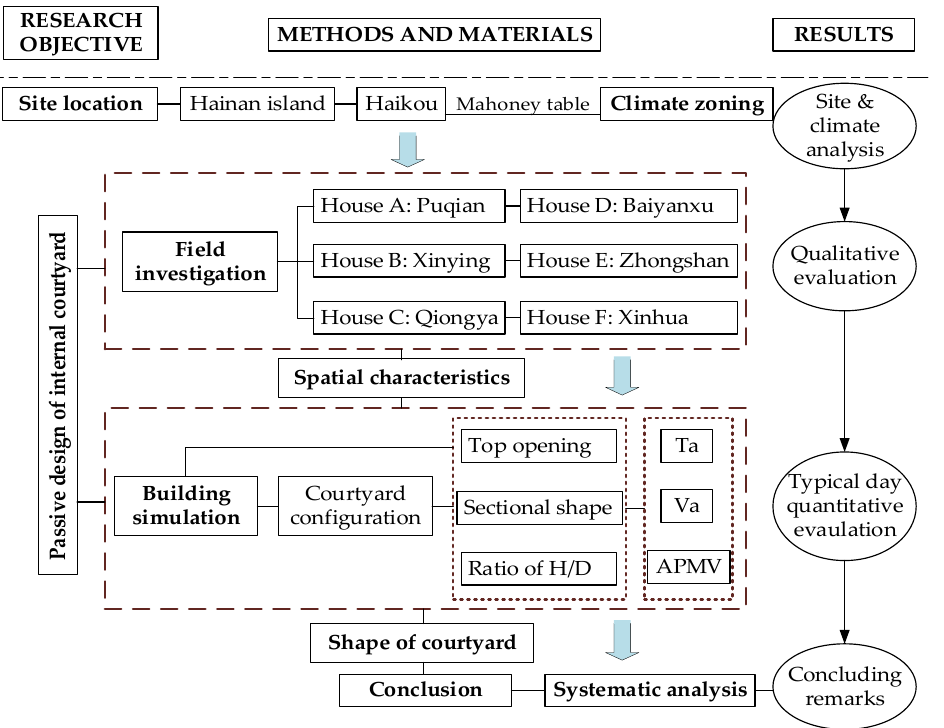
Figure 2. Research method